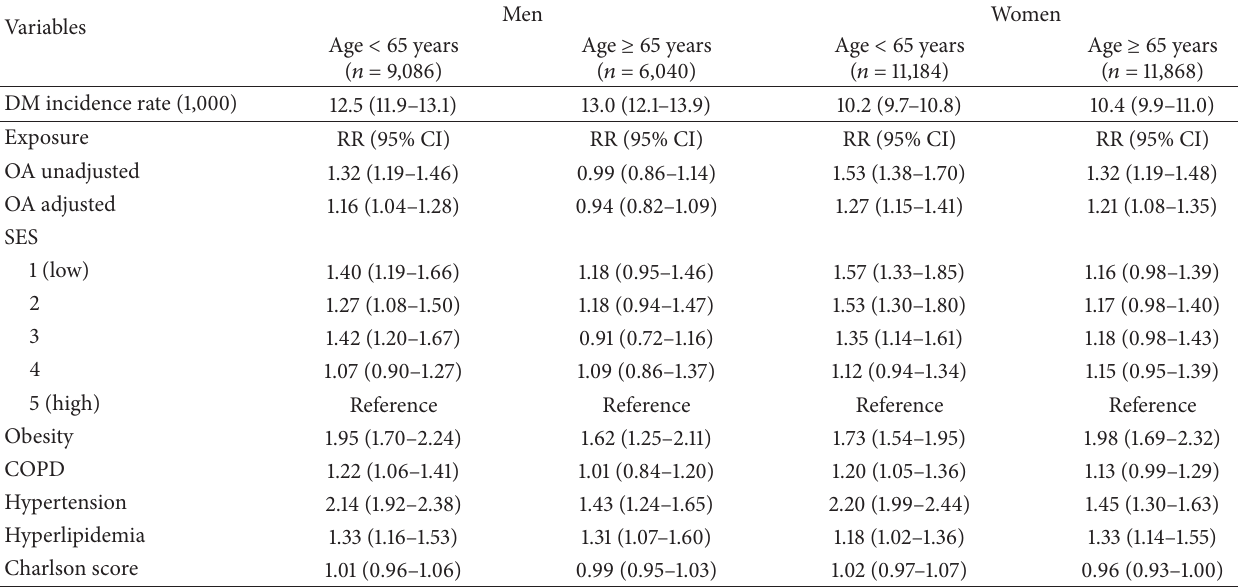
Table 2: Age-sex specific incidence rate per 1000 person years, relative risks (RRs), and the 95% confidence intervals (CIs) of diabetes mellitus